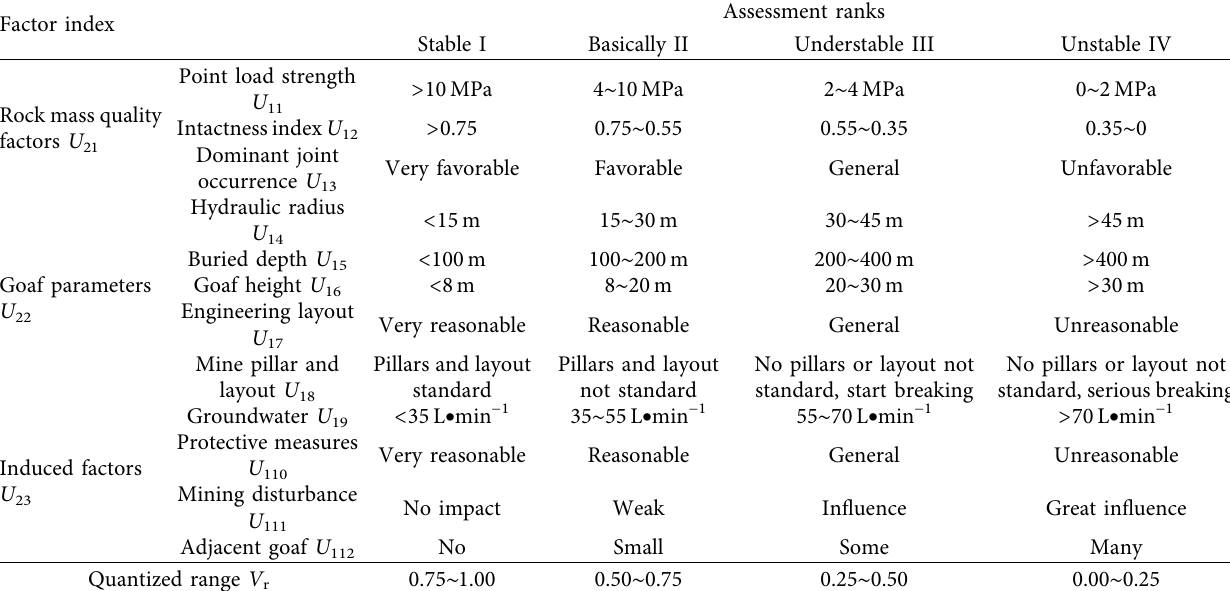
Table 1: Te classifcation of goaf